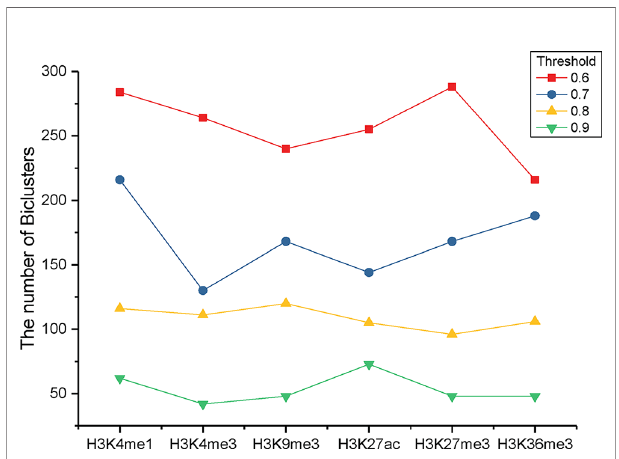
FIGURE 3 | The numbers of bi-Clusters with varied similarity thresholds for different epigenetic